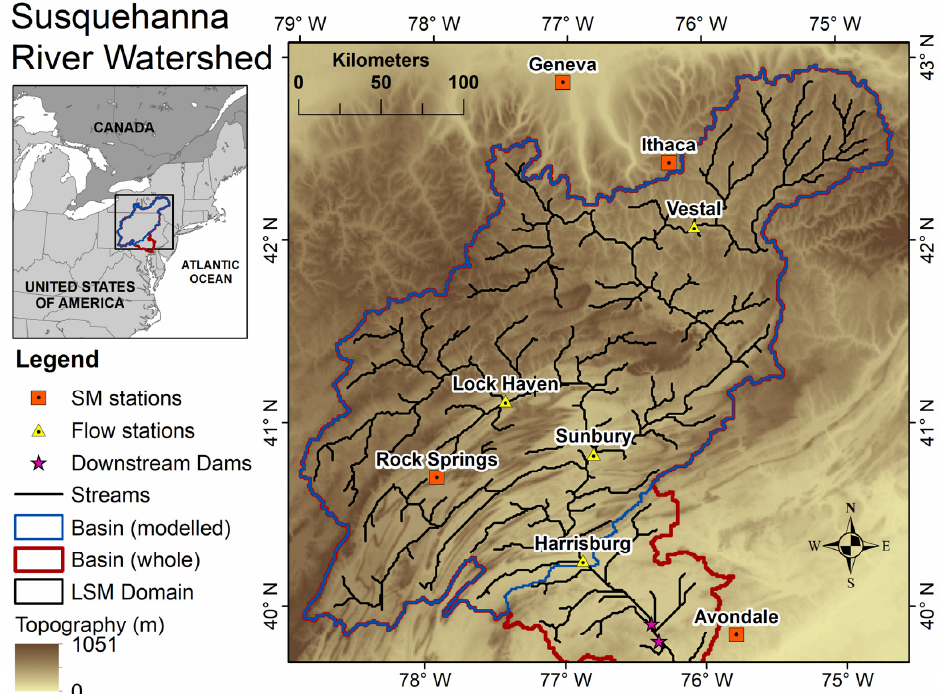
Figure 1. Topography of the Susquehanna River watershed and the locations of the in-situ streamflow and soil moisture measuring stations. The complete watershed is shown in red, and the modelled portion of the watershed is shown in blue which excludes the large downstream dams.